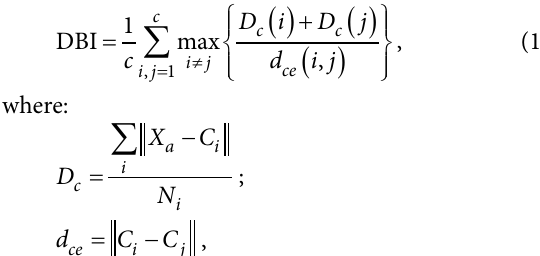
Map layers GM Road network EEH LBS Road WEH SV